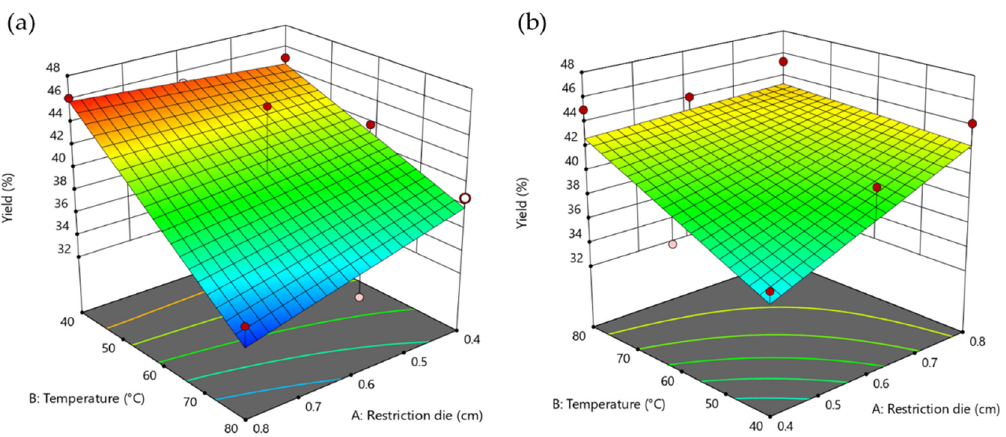
Figure 1. Response surface plot showing the effect of temperature and restriction die size on yield of CSO. ( a ) Sieve size: >1.4 mm, ( b ) Sieve size: <1.4 mm.